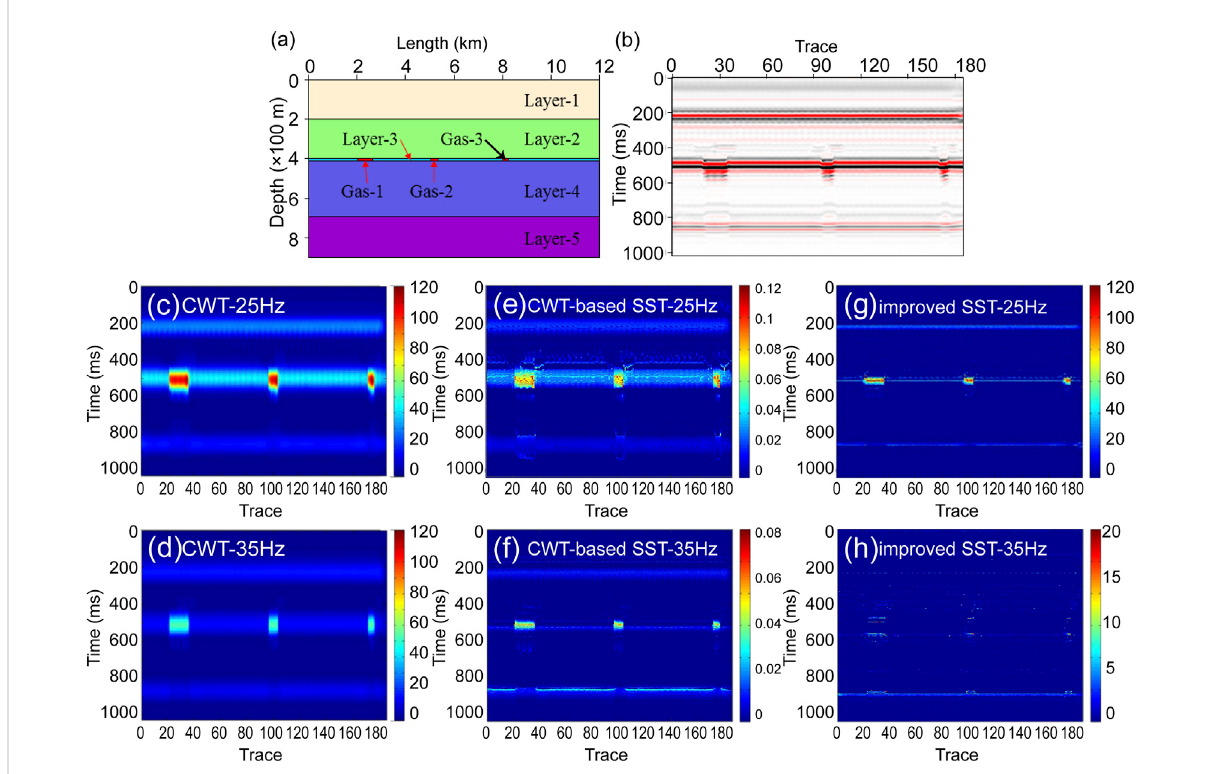
FIGURE 4 Application of the 2-D horizontal model and analysis of the instantaneous frequency used the isofrequency section. (A) Forward model with horizontallayers.Thethirdlayercontainsthreegaslayerswithlargetransversewidthvariations.ModeldataarecreatedbyusingtheTesseral2-D; (B) pre-stack time migration pro fi le of the 2-D forward model. (C) 25 Hz-isofrequency section of the continuous wavelet transform (CWT); (D) 35 Hz- isofrequency section of the CWT; (E) 25 Hz-isofrequency section of the CWT-based SST; (F) 35 Hz-isofrequency section of the CWT-based SST; (G) 25 Hz-isofrequency section of the improved synchrosqueezing transform (SST) in this study; (H) 35 Hz-isofrequency section of the improved SST (these are all plotted with MATLAB, with the “ jet ” colormap; red indicates higher amplitude).